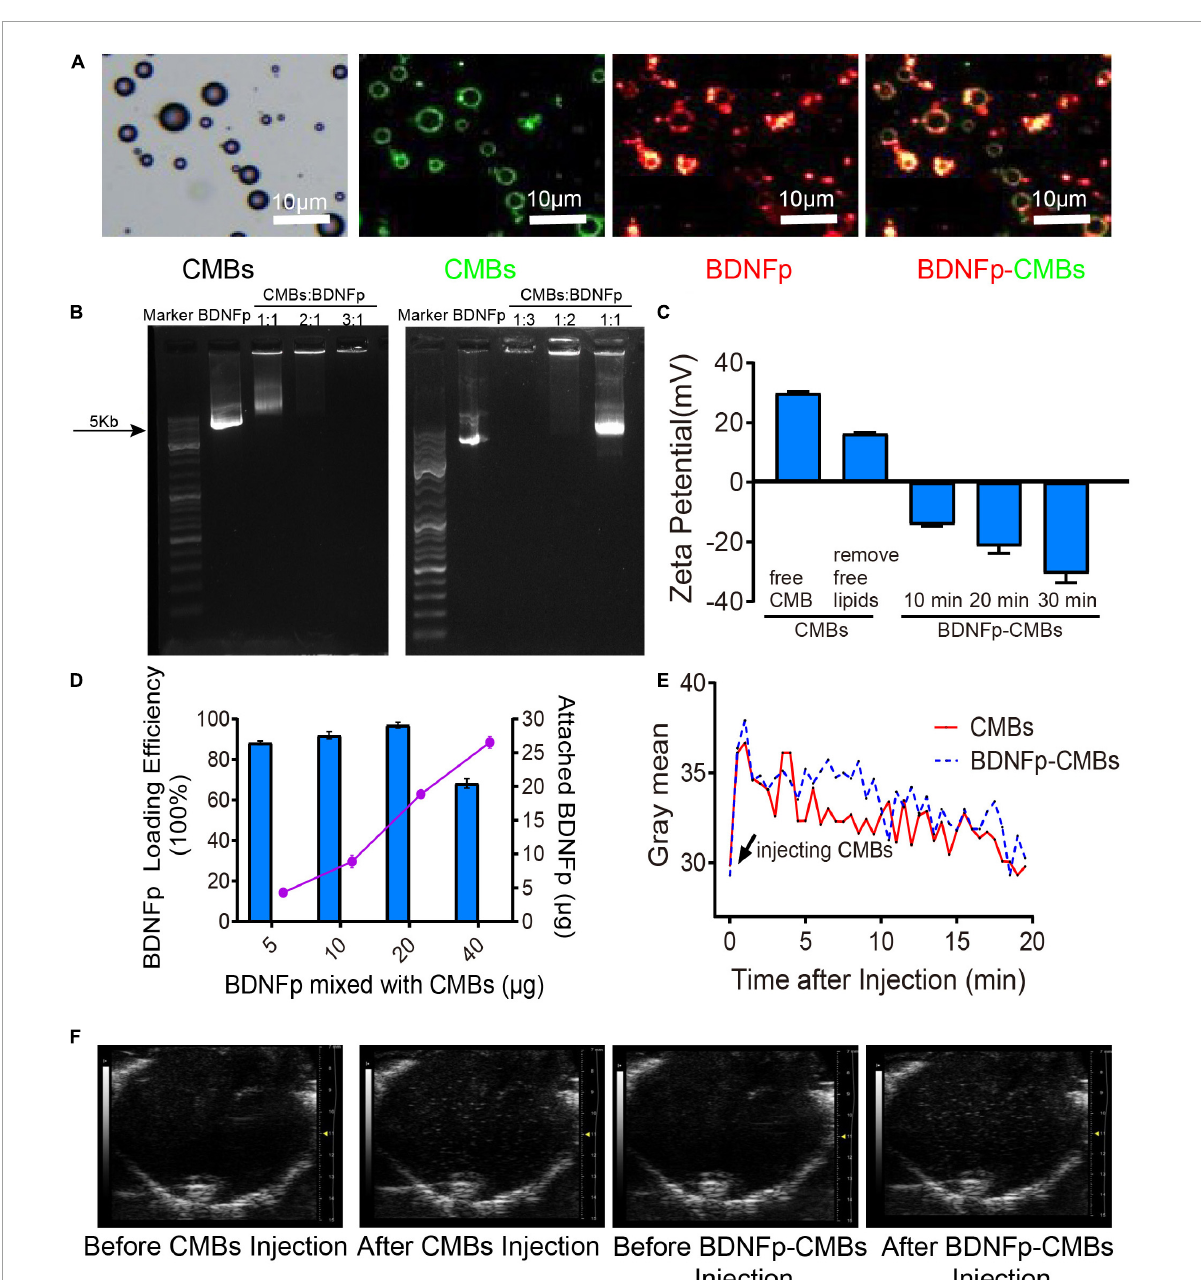
FIGURE2 Preparation and characteristics of cationic microbubbles loading brain-derived neurotrophic factor plasmid (BDNFp-CMBs). (A) BDNFp adhered to the surface of CMBs under an ordinary optical microscope and in situ fluorescence microscope. (B) BDNFp-CMBs agarose gel electrophoresis. (C) CMBs and BDNFp-CMBs zeta potentials. (D) Adsorption efficiency of BDNFp and CMBs. (E) The time-intensity curves of CMBs and BDNFp-CMBs following tail vein injections. (F) Contrast-mode imaging of two types of microbubbles in the brains of mice before and after tail vein injection of CMBs and